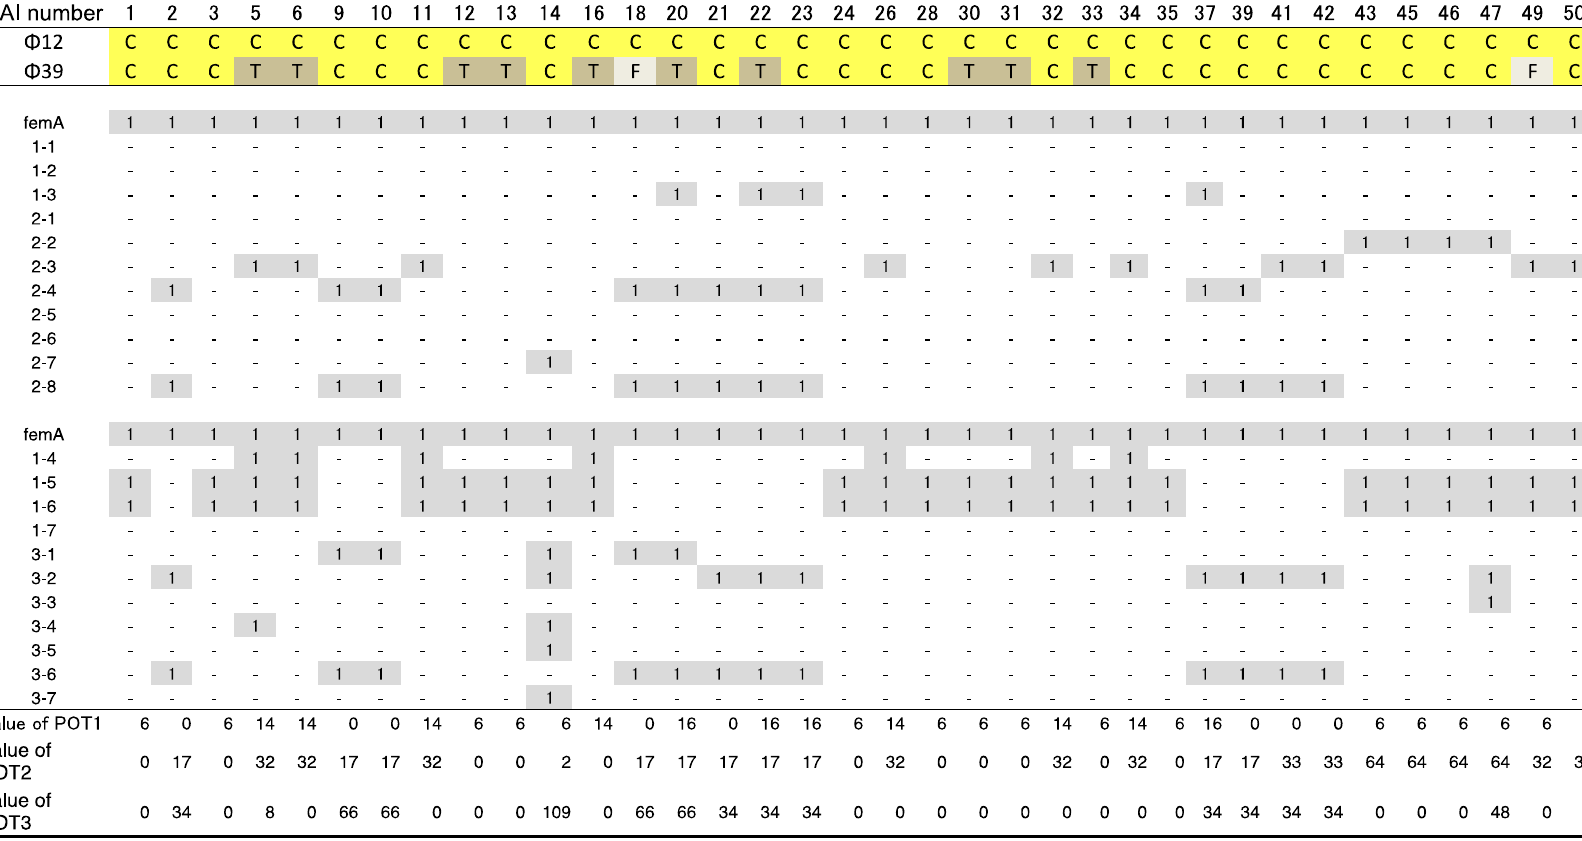
Table 2. Host ranges of S. aureus phages, Φ SA012 and Φ SA039, against S. aureus isolated from mastitic cows in Ishikari.